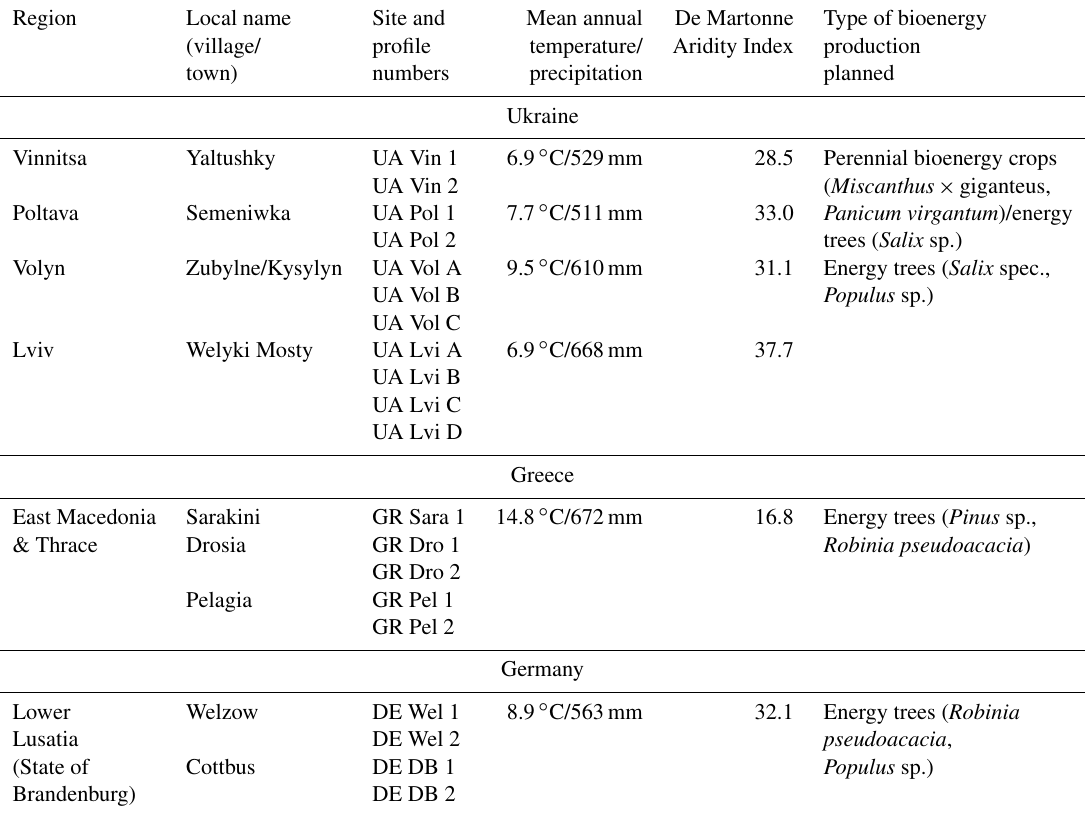
Table 1. Overview of investigated case study sites: locations, climatic conditions, and cultivated bioenergy